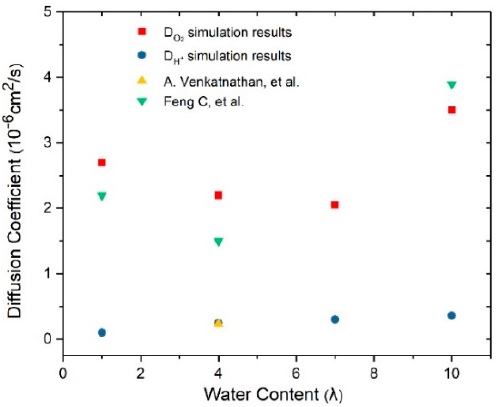
Figure 7. Diffusion coefficient of oxygen and hydronium ions as a function of water content.